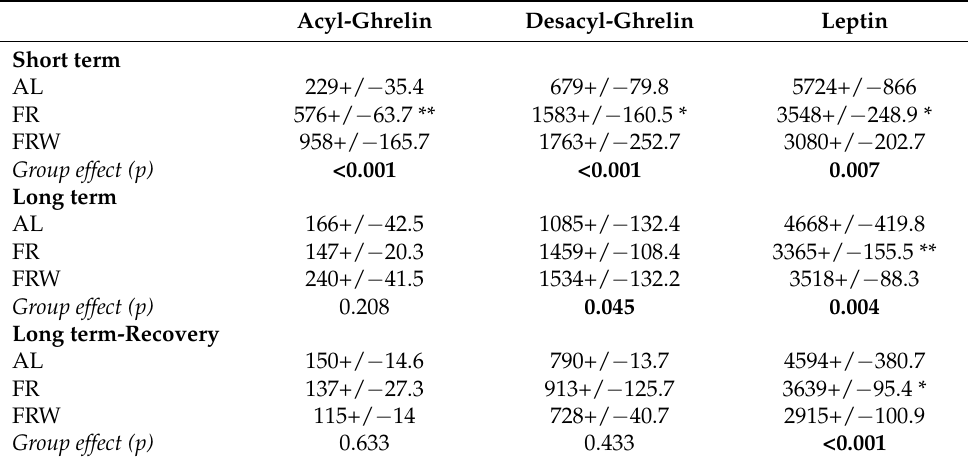
Table 7. Acyl ghrelin, desacyl ghrelin and leptin plasma levels in short-term, long-term and recovery mice protocols. Significant values are in bold. Data are expressed in mean +/ − SEM or p